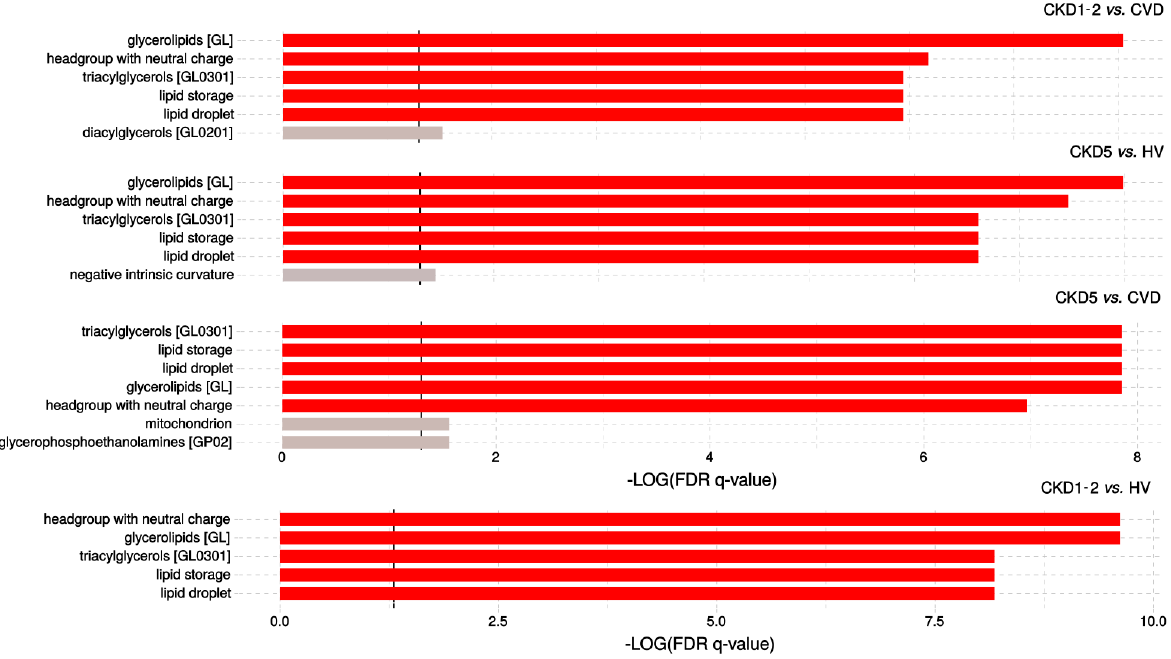
Figure 5. LION-term enrichment analysis of CKD1-2 vs. CVD, CKD5 vs. HV, CKD5 vs. CVD and CKD1-2 vs. HVs presented in the “ranking mode”. The gray vertical lines indicate the threshold of –log10 False discovery rate (FDR)-corrected p -value 0.05 ( q -value 1.3). Red bars present terms with FDR-corrected p -value < 0.01 ( q > 2).